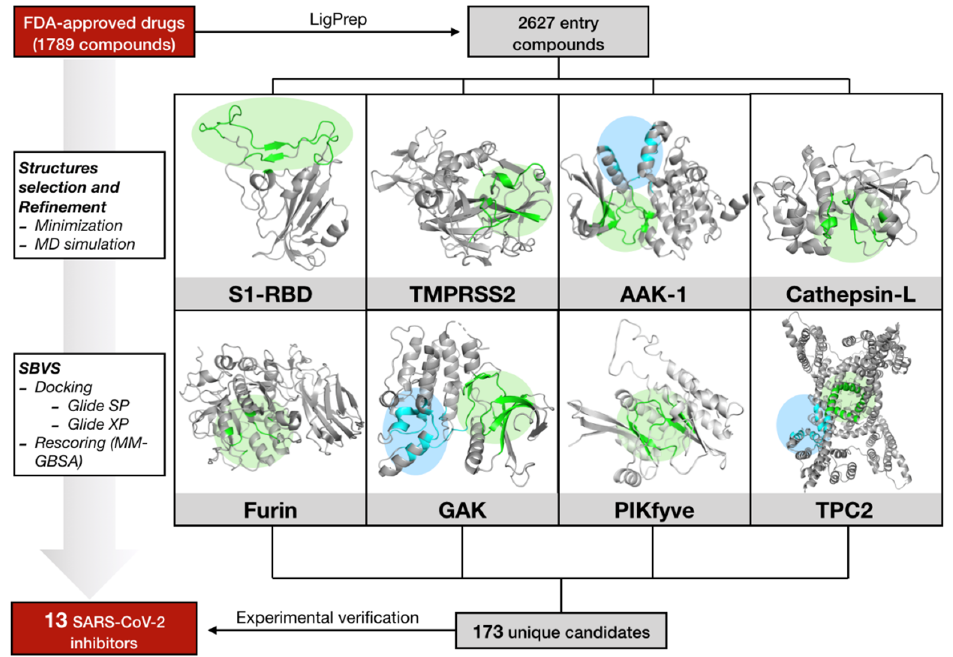
Figure 2. Schematic representation of the computational protocol applied in this study. For each target, green and blue circles respectively mark the active and the allosteric/secondary binding sites.